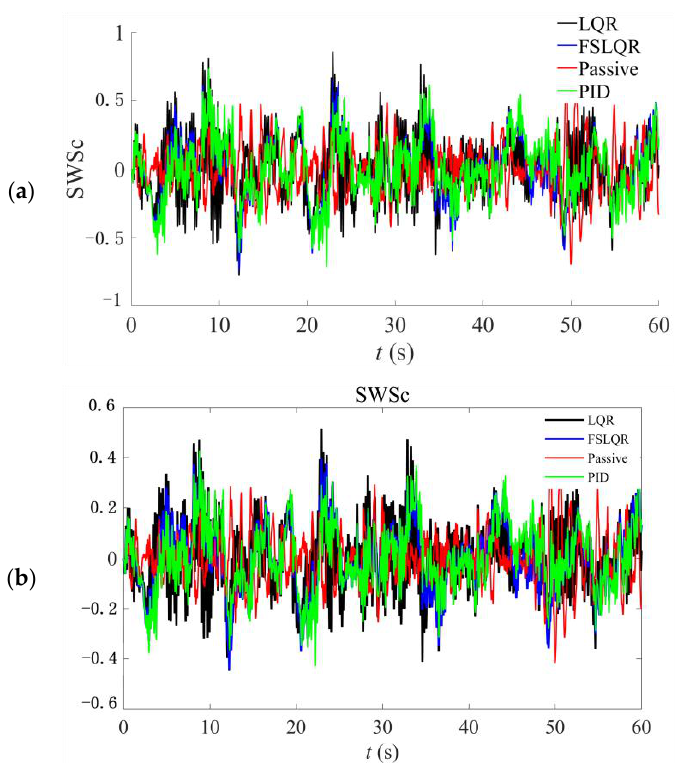
Figure 7. The suspension dynamic travel coefficient responses of SWSc under random excitation, ( a ) under the national standard C-grade road surface, ( b ) under the national standard B-grade road surface.